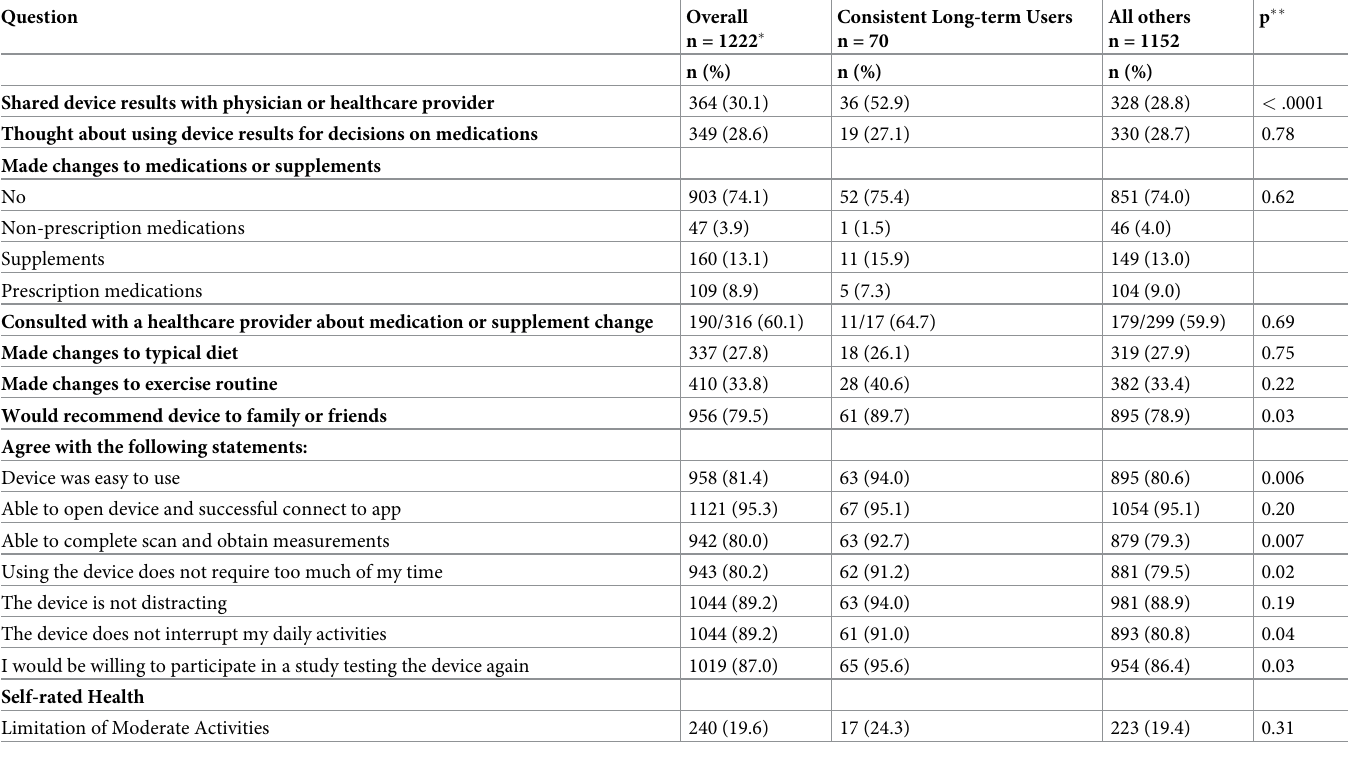
Table 4. Attitudes and behaviors of participants answering surveys at 12 months by amount of device